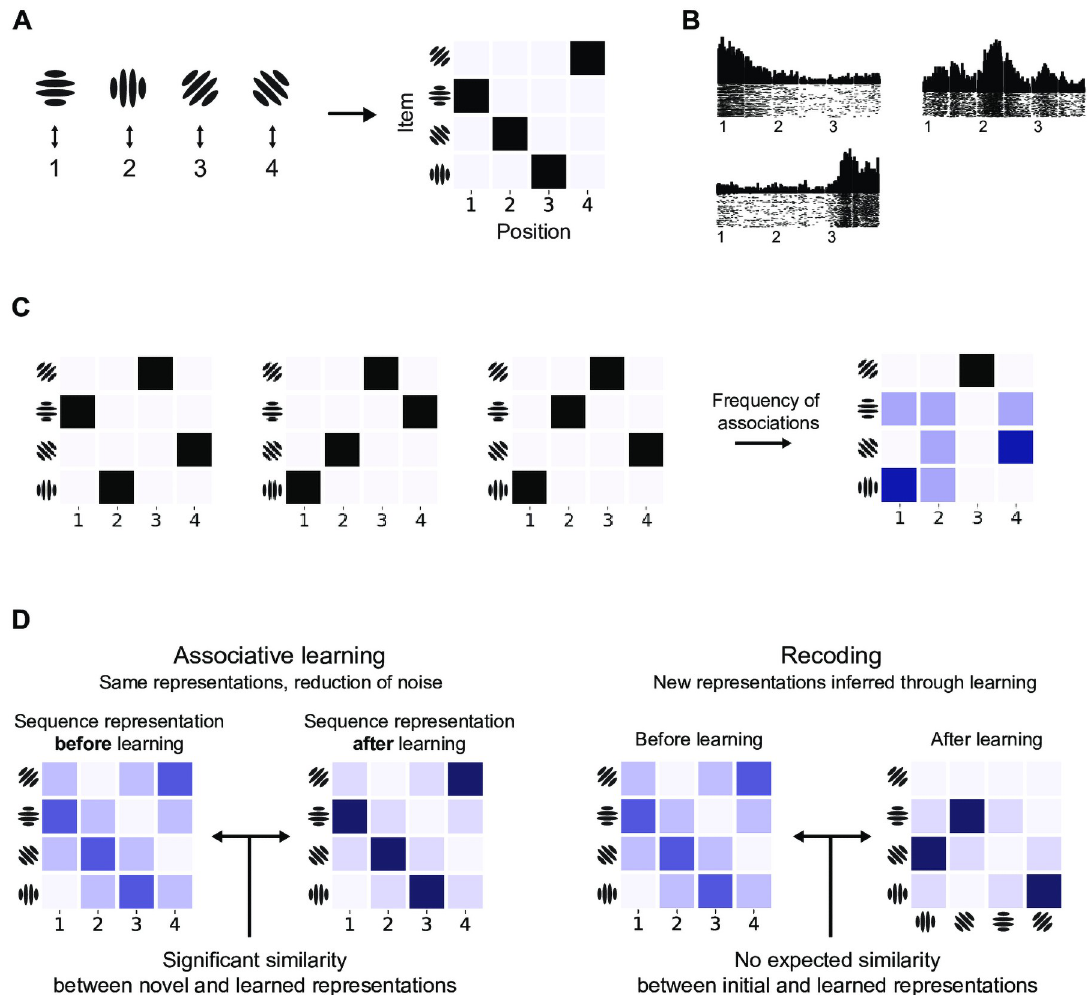
Fig 1. Sequence learning. (A) Four Gabor patches (items used in this study) associated with four sequence positions and a matrix representation of the sequence. (B) Item-position associations in monkey prefrontal cortex as observed by Berdyyeva et al. [38]. Each subplot displays spiking activity for a particular neuron: the first one responds most to items at the beginning of a three-item sequence, the second for the ones in the middle, and the last one for items at the end of the sequence. Numbers on x-axis mark the onset of the stimulus events. (C) Visual representation of three sequences as position-item associations and the resulting frequency of associations. The frequency of associations can be learned as a model of the environment. (D) Dissociating between learning mechanisms in terms of similarity between novel and learned sequences: with associative learning (left) learned sequences share the same item codes with novel ones. Furthermore, learning reduces noise in learned sequence representations. Recoding (right) changes item representations so that novel and learned stimuli do not share